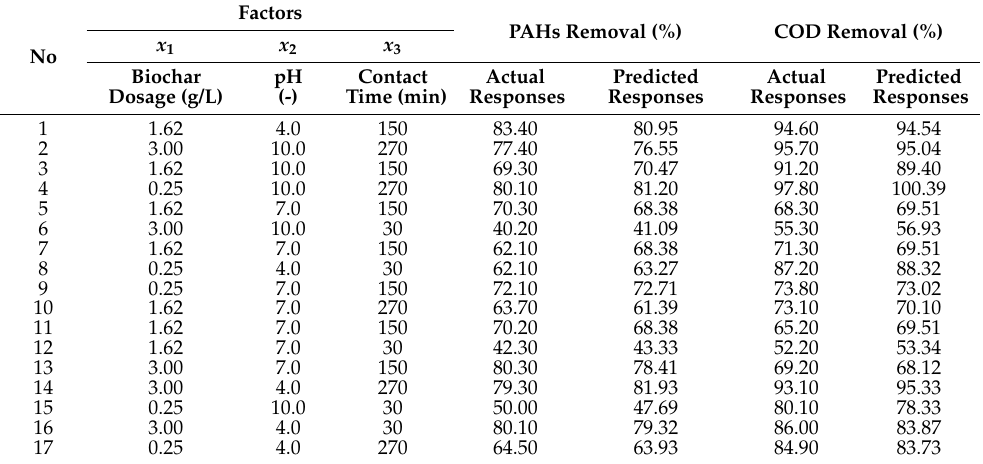
PAHs Removal (%) COD Removal (%) Actual Predicted Actual Predicted Responses Responses Responses